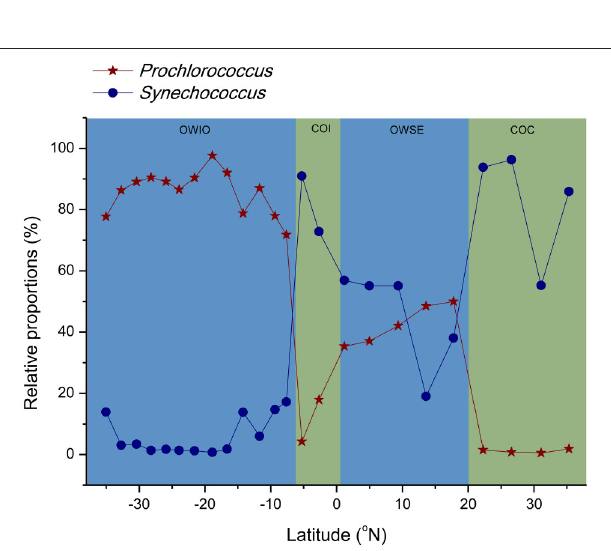
FIGURE 6 | Trends of relative abundance for Prochlorococcus and Synechococcus in Cyanobacteria phylum along latitude. OWIO, open sea stations from Indian Ocean; OWSE, open sea stations from semi-close marginal seas; COI, coastal stations in Indonesia; COC, coastal stations in